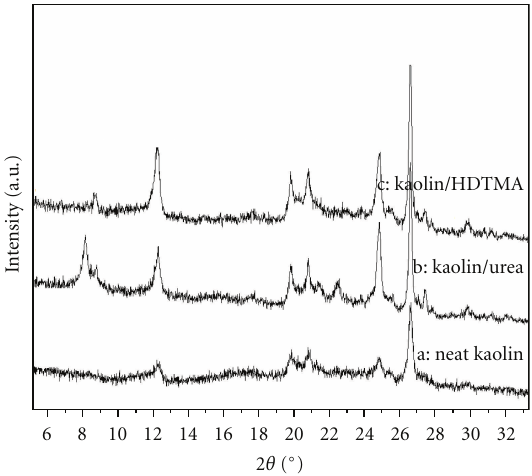
Figure 2: X-ray di ff raction curves of neat kaolinite and kaolin/urea and kaolin/HDTMA mixtures.